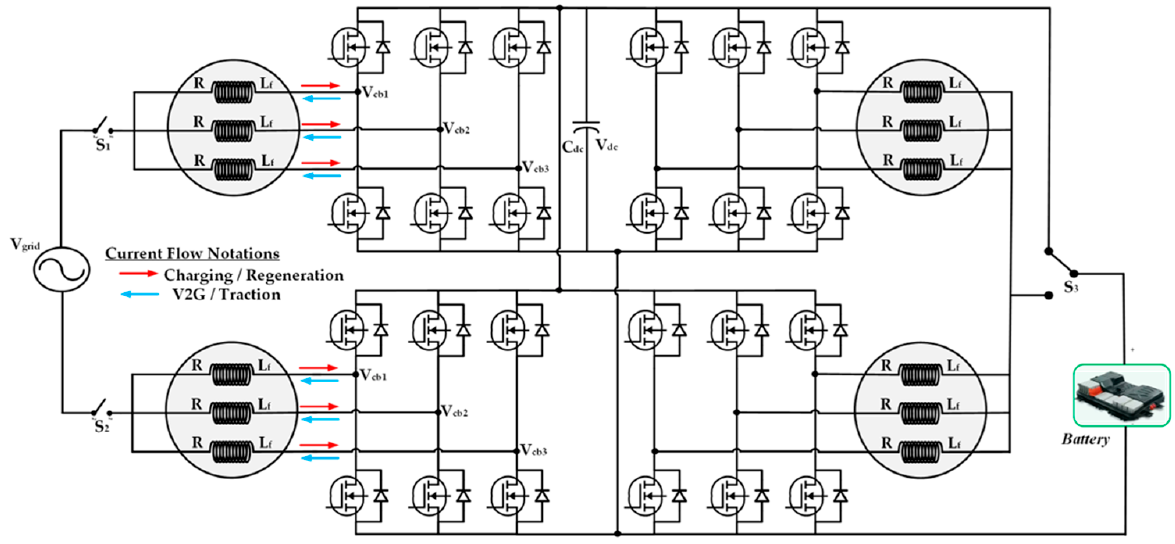
Figure 6. Dual motor drive integrated on-board charger proposed by Woo et al. [62] in 2015 (iOBC2).